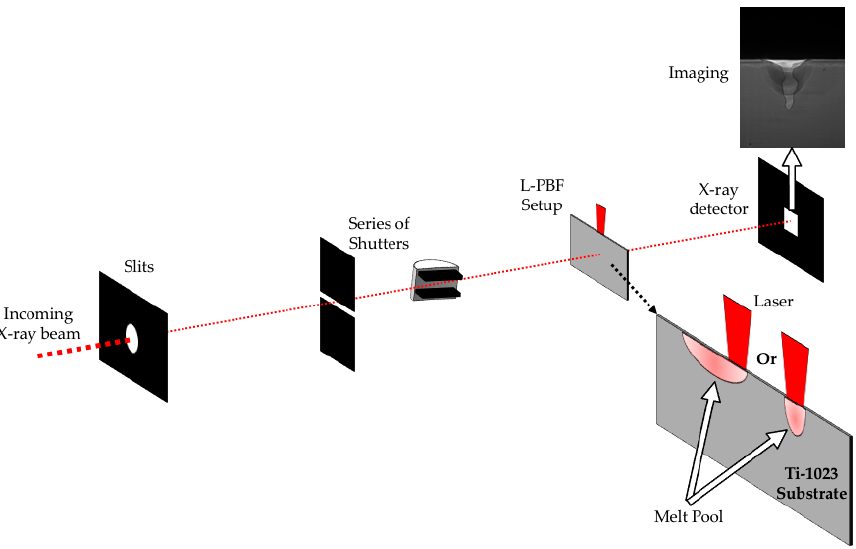
Figure 1. Schematic of the X-ray imaging L-PBF simulator experiments on the Sector 32-ID-B beamline at the APS at ANL. Note: distances between components not to scale.